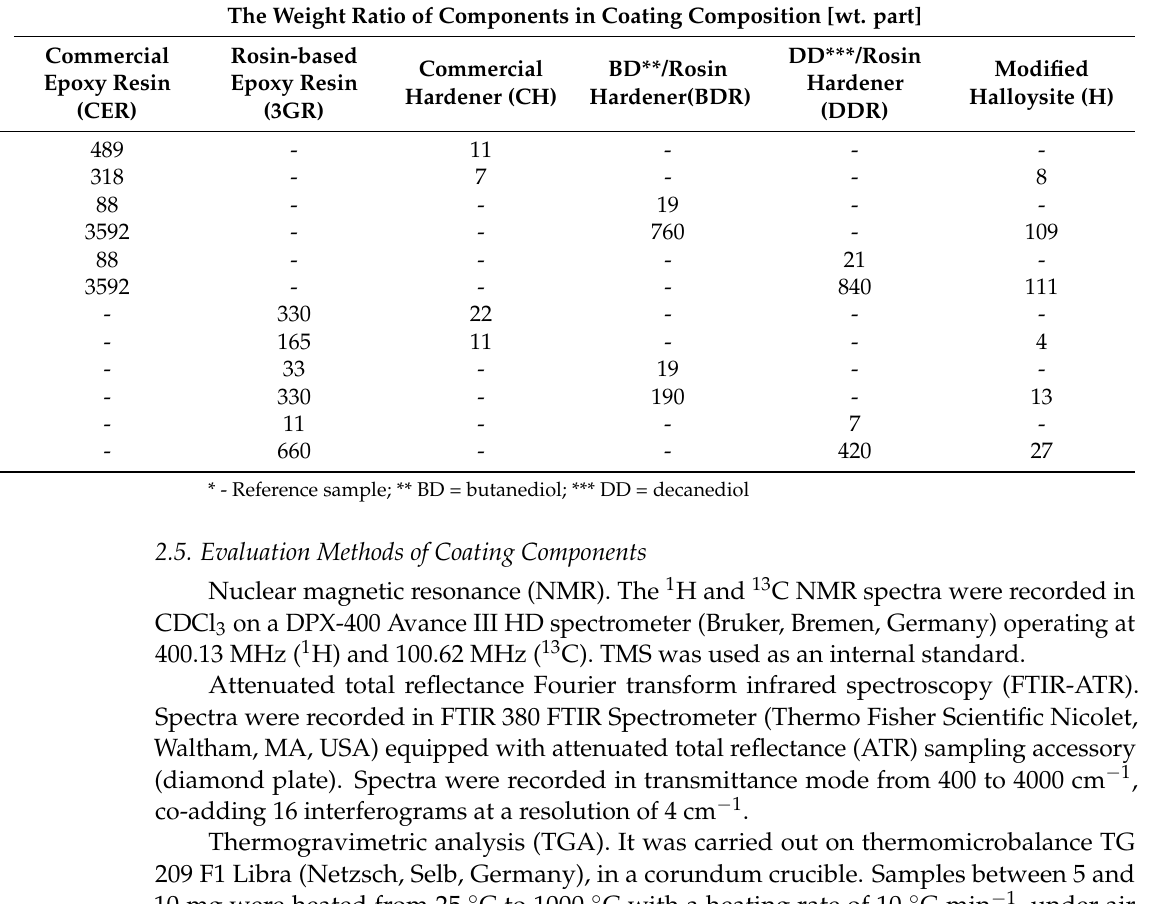
Table 1. Symbols and composition of the prepared